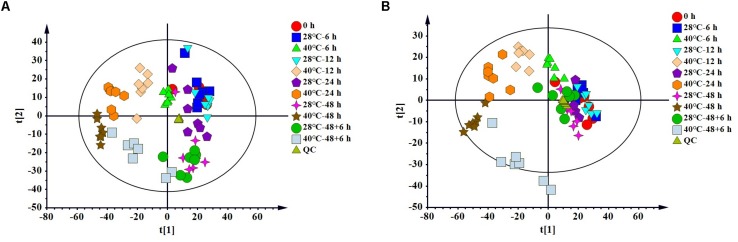
The PCA score plot of LC-MS data of all P. ostreatus samples. (A) The positive mode, (B) the negative mode.